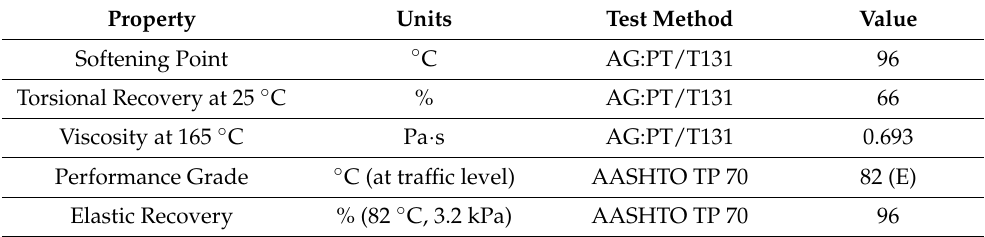
Table 2. A10E bituminous binder properties [36].